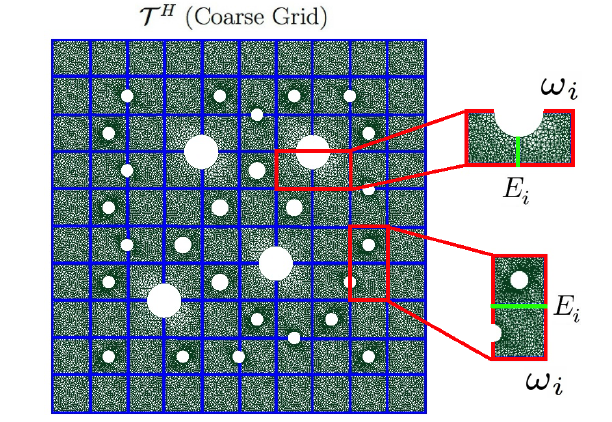
Figure 2. Illustration of a coarse grid and local domain ( ω i ) for the Magnetic field